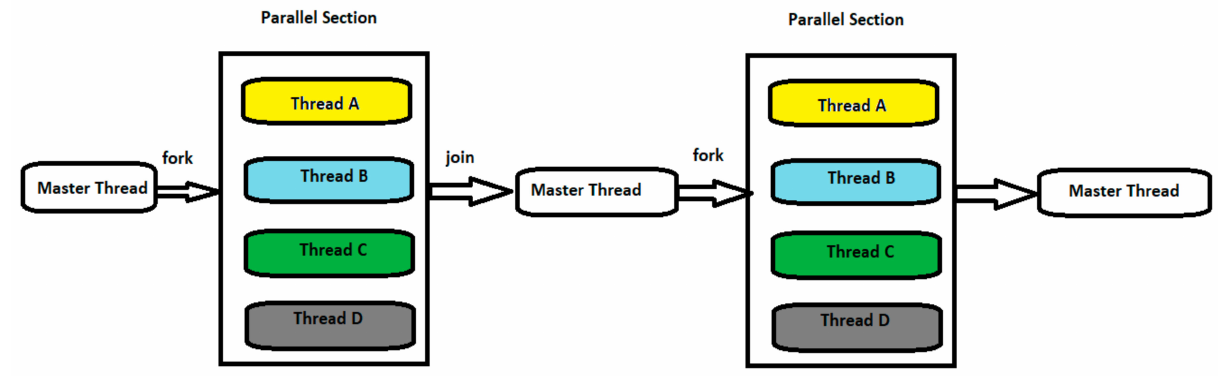
Figure 1. Master and worker threads in a fork–join programming